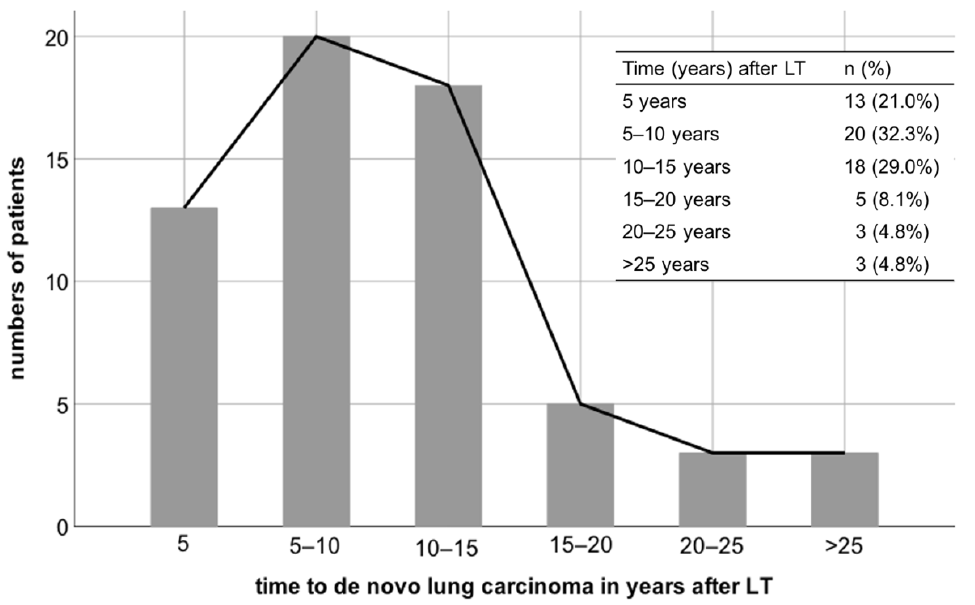
Figure 1. Time of diagnosis of de novo lung carcinoma after liver transplantation. LT—liver transplantation.